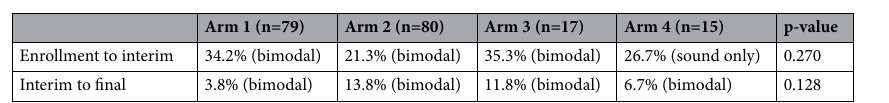
Table 3. Percentage of participants with increased tinnitus AE for each arm and stage of treatment relating to AEs listed in Table 2. P-values were calculated for comparing across arms using Fisher’s exact test. There were 71 total cases for the two stages listed (8 additional cases occurred outside of these two stages).